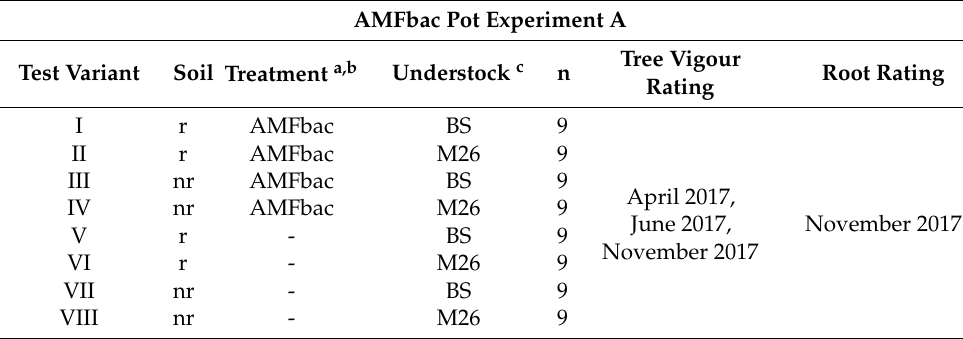
Table 4. AMFbac Pot Experiment A (April to November 2017) (32 weeks) ( n = 72).